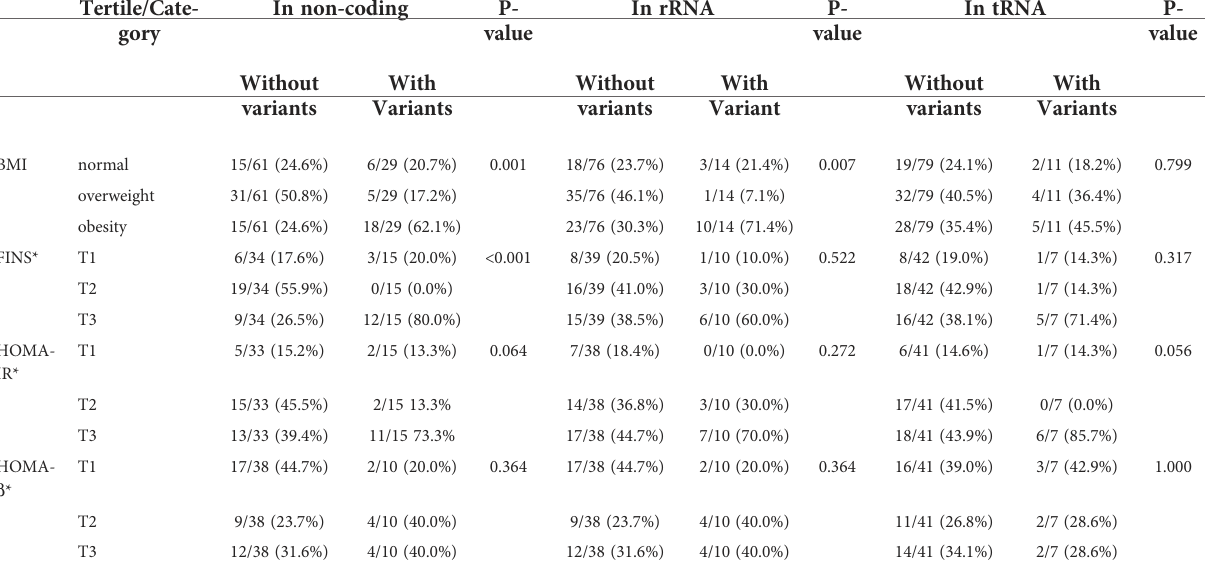
TABLE 6 Comparison of BMI and other traits among the patients with variants and without these variants in the non-coding region, transfer RNA, and rRNA of mitochondria.